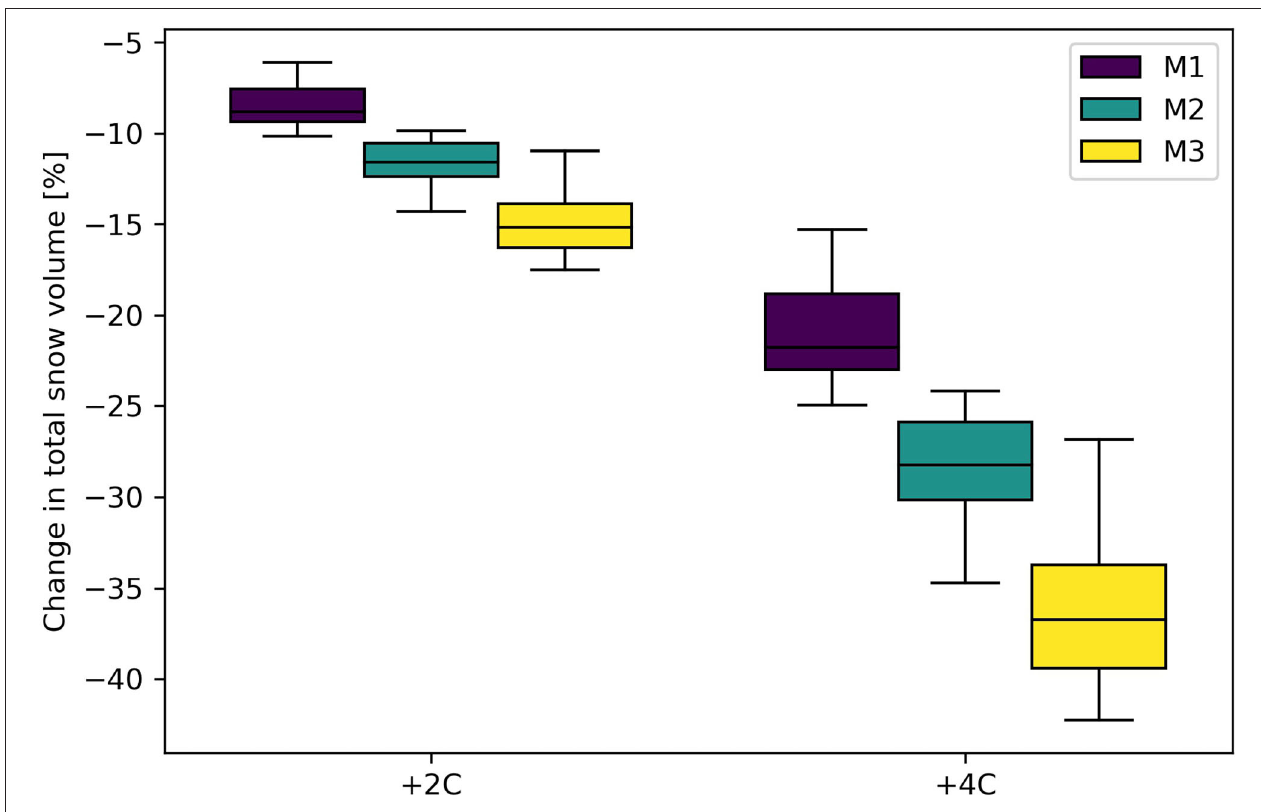
FIGURE 6 | Changes in total snowpack volume for three different classes of basin hypsometry and two temperature scenarios, based on 50 normalized area-elevation